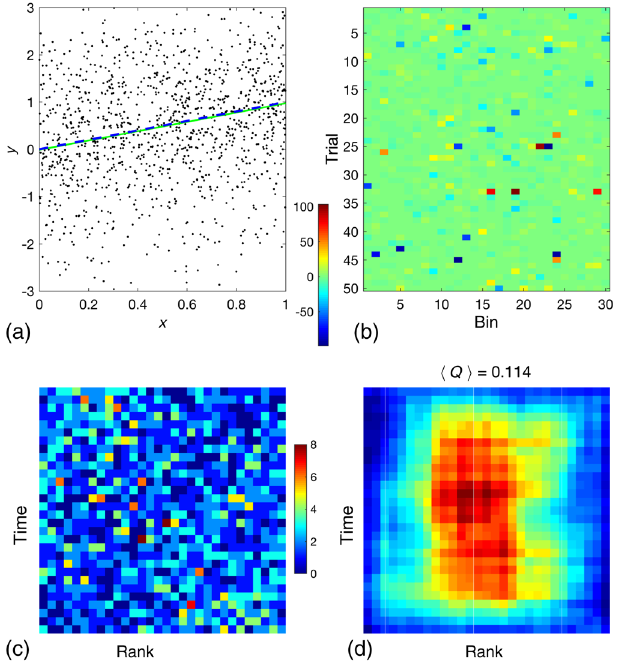
FIG. 15. Application of Q to general data fitting. (a) A sample of 1500 data points ( x values) drawn from a uniform distribution. The y values show a linear trend plus noise from a Cauchy distribution. The vertical range is truncated to show the local fit, but the actual data range over ½ − 100 ; 100 (cid:3) . (b) While randomly space sample points seem far from the initial application of linear regression with Q , by suitably grouping these points, we obtain the equivalent of Fig. 1(a). Panel (c) shows the P matrix and panel (d) the Q matrix. Here, Q and, more so, P clearly show the imposed linear trend. The Q fit trend (solid line), supplemented by a local algorithm to estimate the constant term, compares well with the exact trend (dashed